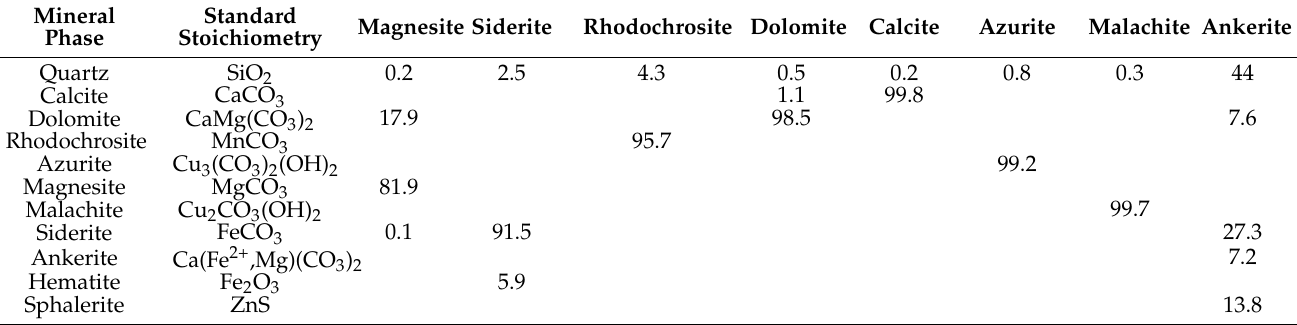
Table 1. Quantitative XRD analyses (wt%) of the carbonate mineral samples. Where a specific mineral was not identified as being present the cell has been left